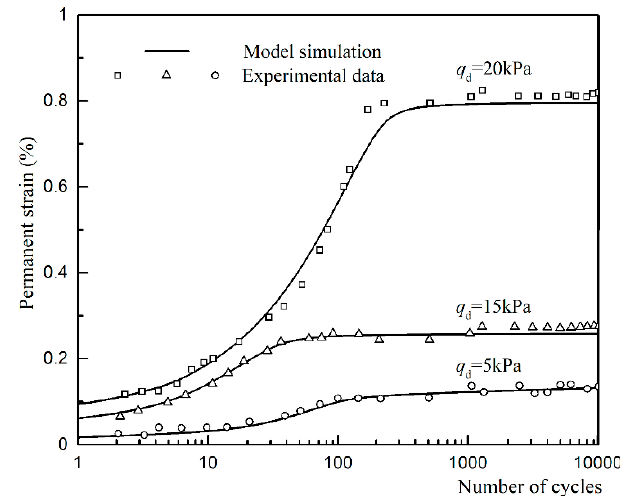
Figure 7. Permanent strain for various amplitudes q d